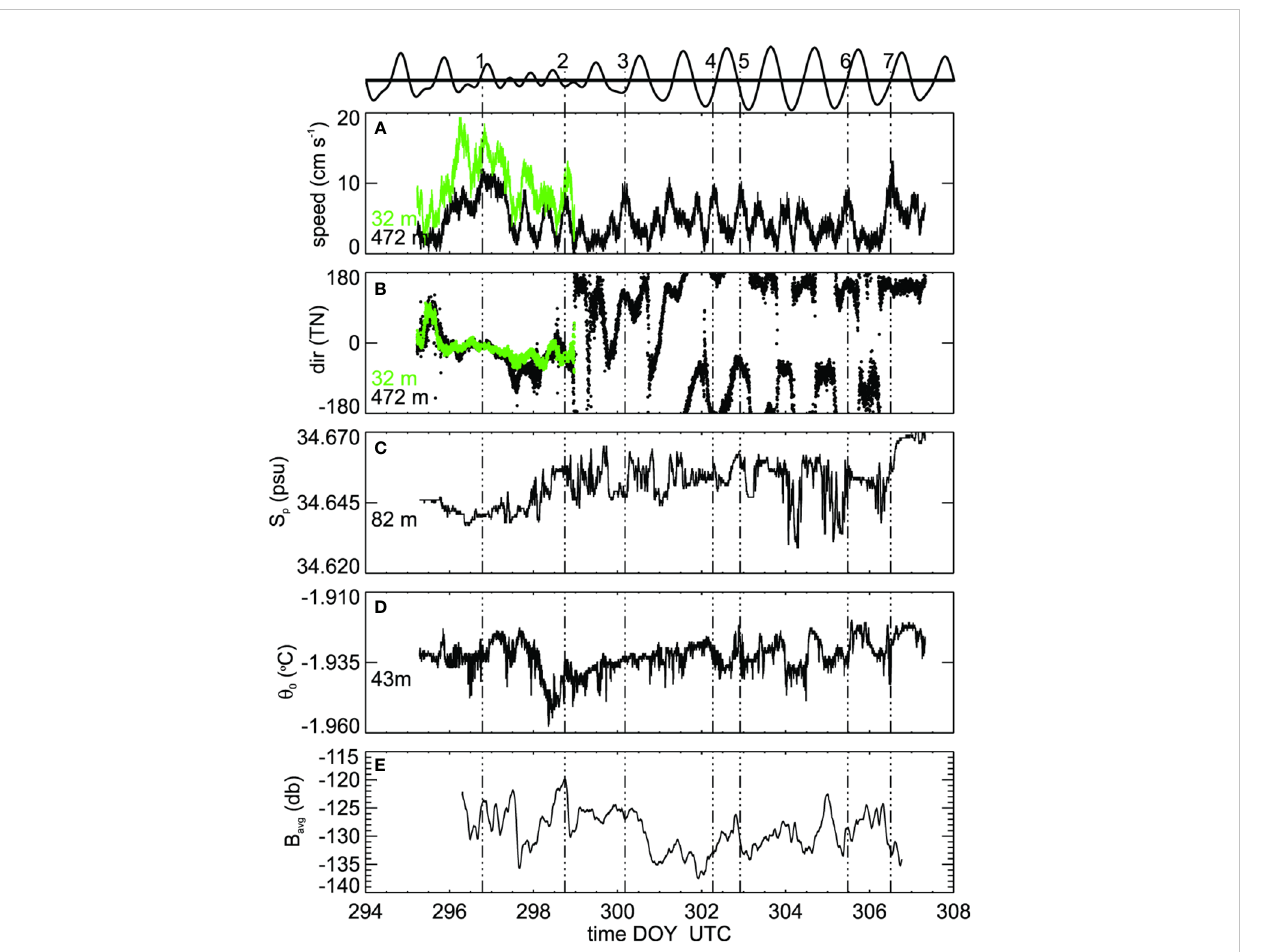
FIGURE 4 Moored instrument data showing timeseries of (A) current meter speed at 472 m, (B) fl ow direction (towards) at 472 m, (C) salinity at 82 m, (D) potential temperature at 43 m and (E) vertically-averaged acoustic backscatter. Panels (A, B) include a short segment from the upper current meter (32 m) prior to ice-up. Selected peaks in speed are highlighted in all panels using vertical dashed lines and the modelled tidal height (http:// tbone.biol.sc.edu/tide) is traced above the top panel where the peaks are